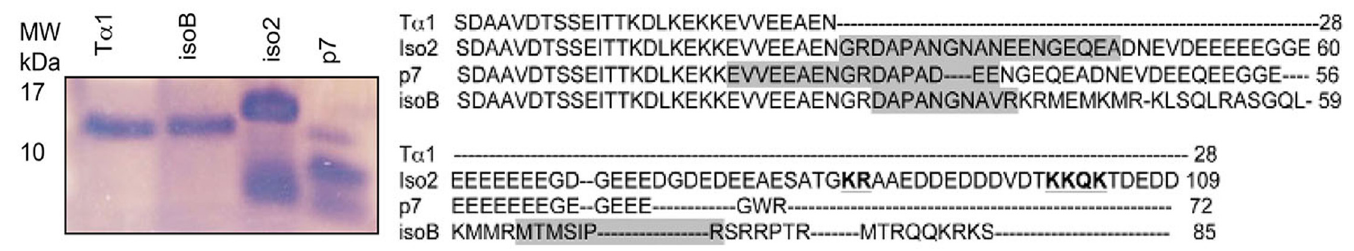
Fig 1. Silver stained PAGE of recombinant ProT α variants and amino acid sequence alignment of ProT α variants. Left panel: silver staining protein visualization of PAGE in which 0.5 μ g of each recombinant ProT α variant was loaded. Right panel: alignment of amino acid sequence of ProT α variants. The peptide sequences identified by mass spectrometry from silver stained gel bands are in grey.